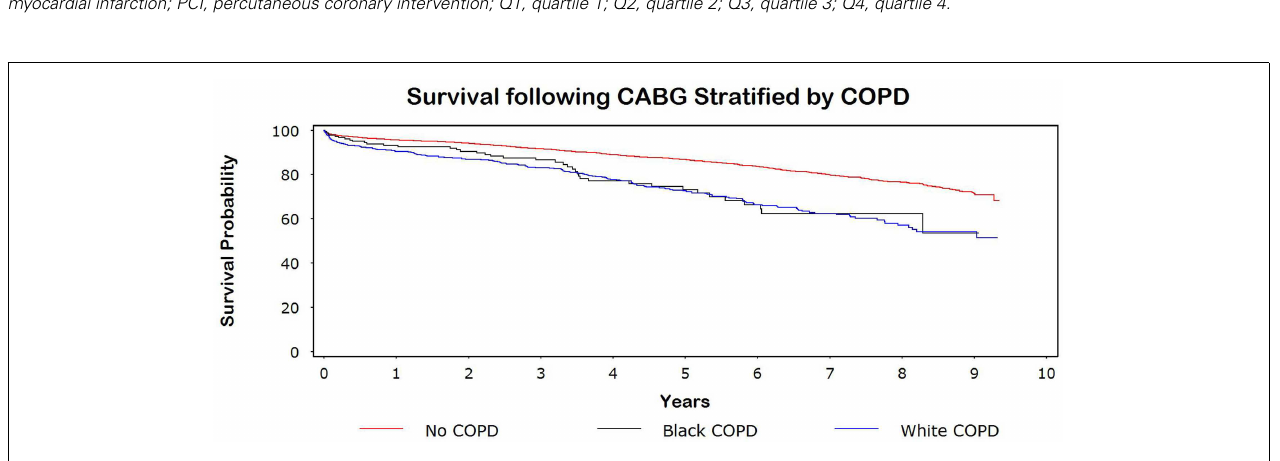
FIGURE 1 | CABG, coronary artery bypass grafting; COPD, chronic obstructive pulmonary